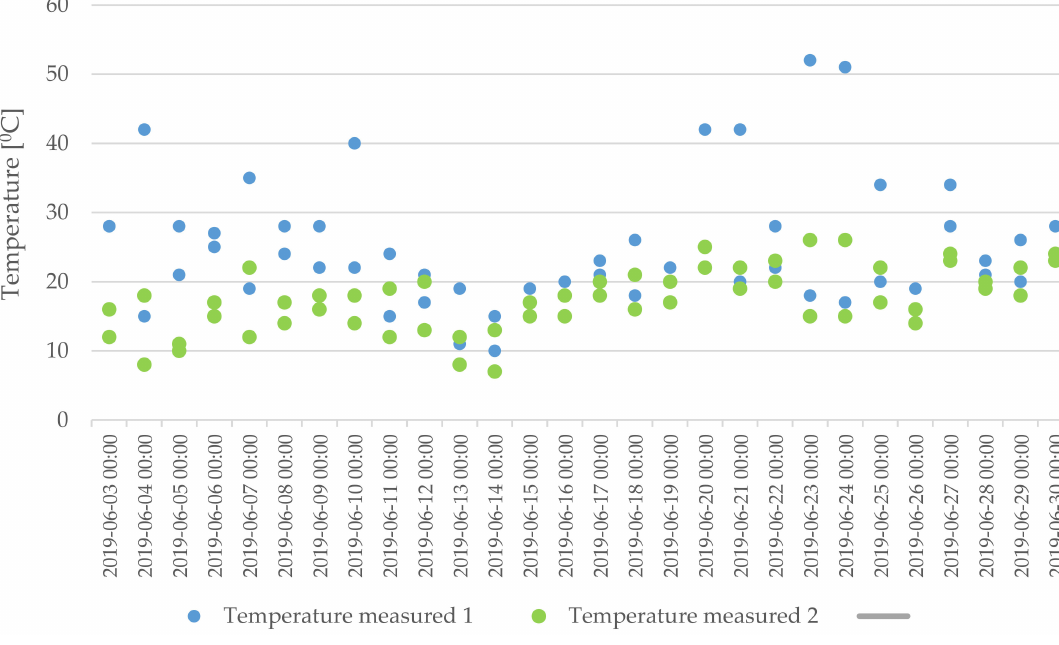
Figure 8. Temperature registration on the sunny part of the